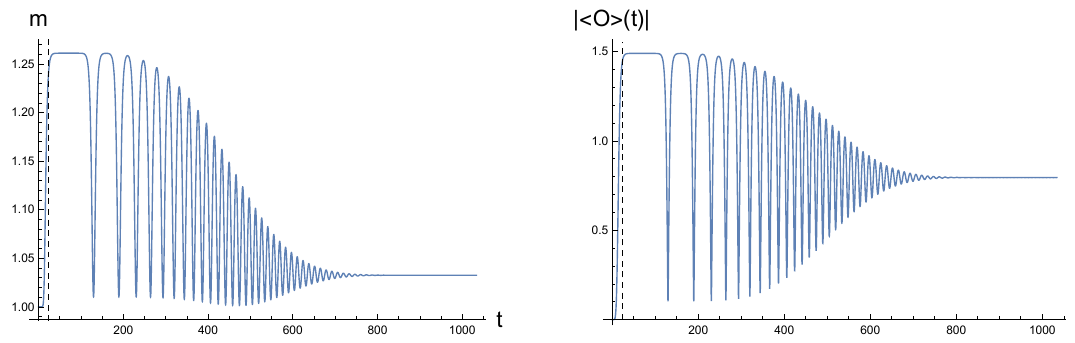
Figure 23 . A close-to-critical quench with build up time scale (cid:12) in = 23 : 811857278 (dashed line) brings AdS close to the unstable attractor, where is stays for a long time before decaying to the modulated SMS. The initial time given by the dashed vertical line. A quasistatic quench then turns the driving amplitude very slowly o(cid:11) (cid:12) out = 1000 and leaves a very slightly perturbed BS at the